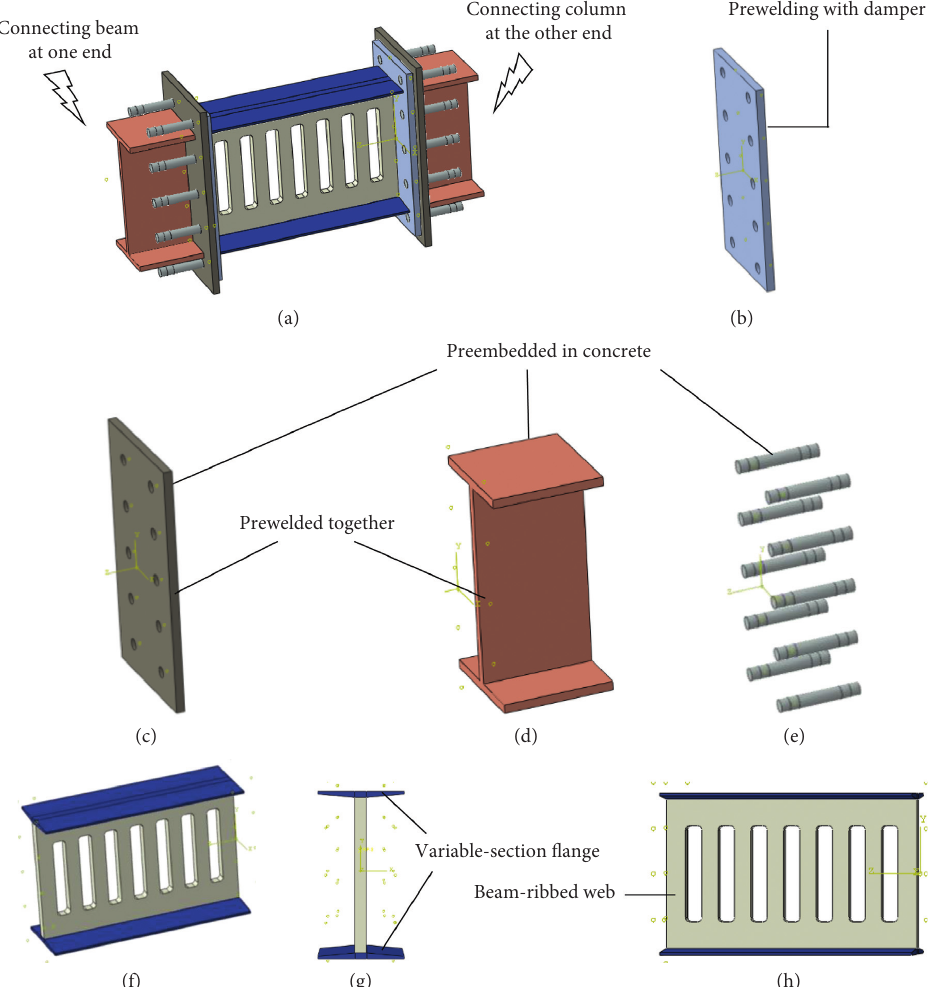
Figure 1: Structure of the slotted damper. (a) Damper and its connection, (b) connecting plate 1, (c) connecting plate 2, (d) anchor plate, (e) high-strength snails, (f) damper, (g) front view of damper, and (h) side view of damper.